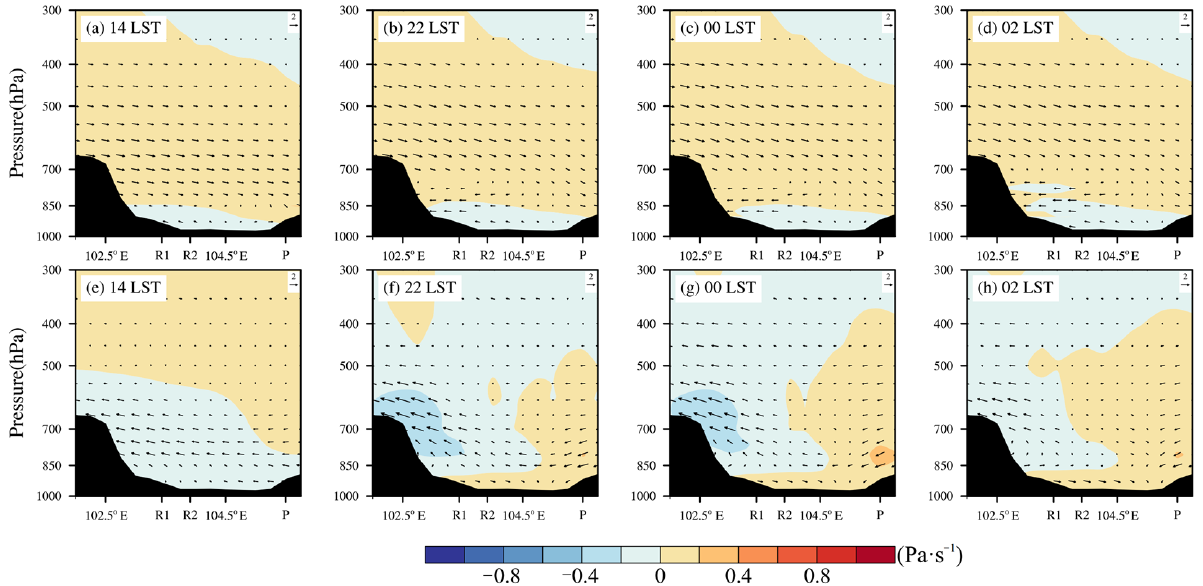
Figure 12. The vertical velocity forced by ( a – d ) the geostrophic creeping flow and ( e – h ) the ageostrophic creeping flow.